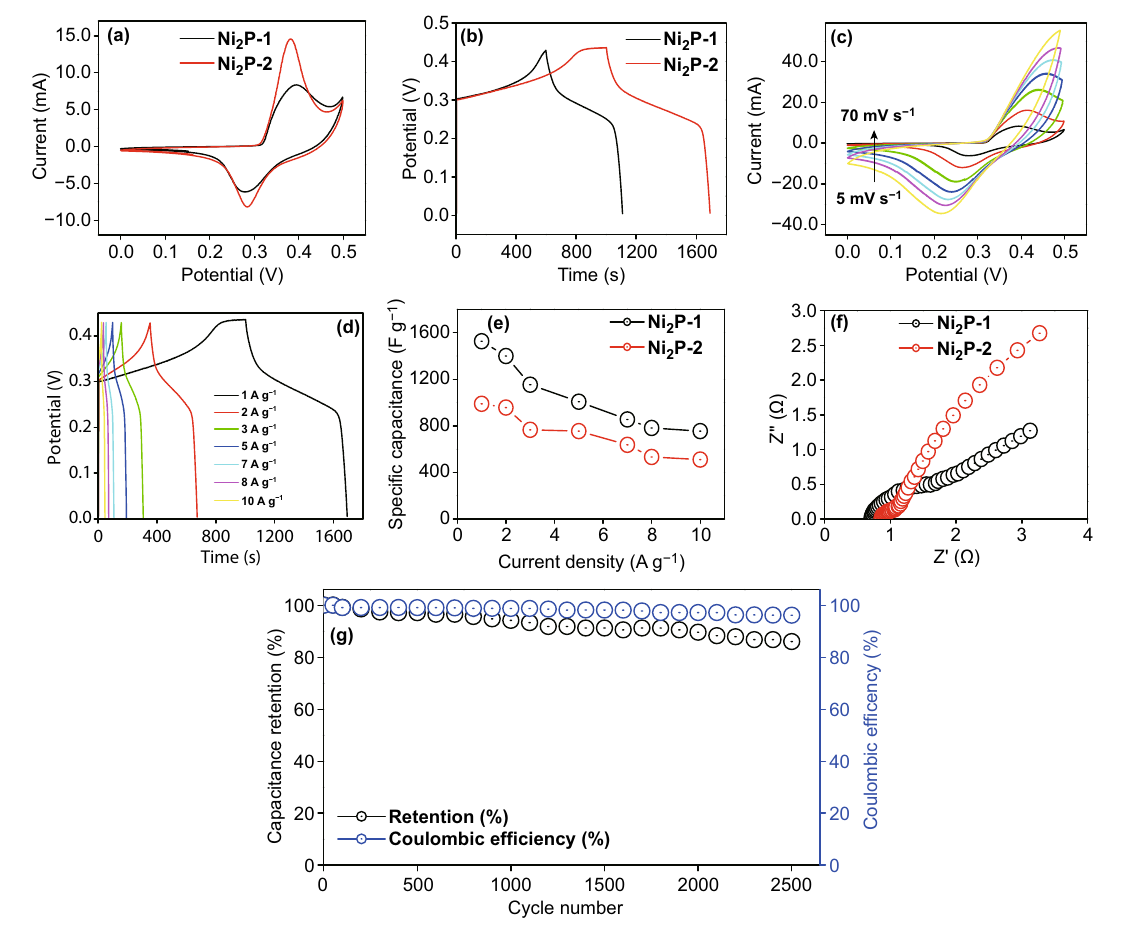
Fig. 9 a Comparative Ni 2 P‑1 and Ni 2 P‑2 CV curves at a fixed scan rate. b Comparative Ni 2 P‑1 and Ni 2 P‑2 GCD curves at a fixed current load. c Ni 2 P‑2 CV curves at different scan rates. d Ni 2 P‑2 GCD curves at different current loads. e Calculated Ni 2 P‑1 and Ni 2 P‑2 specific capacitance. f Ni 2 P‑1 and Ni 2 P‑2 EIS spectra. g Capacitance and coulombic efficiency retention of Ni 2